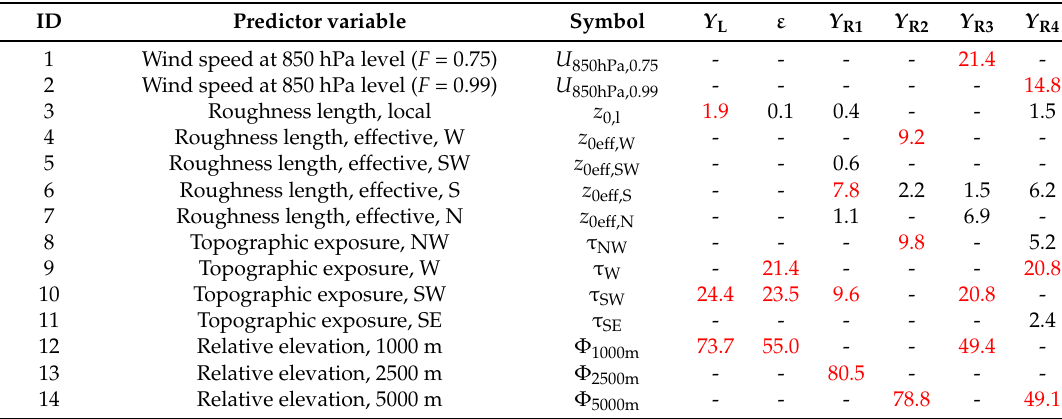
Table 3. Relative importance of predictor variables used for final least squares boosting models (LSBM) in percent. The top three important predictor variables are highlighted in